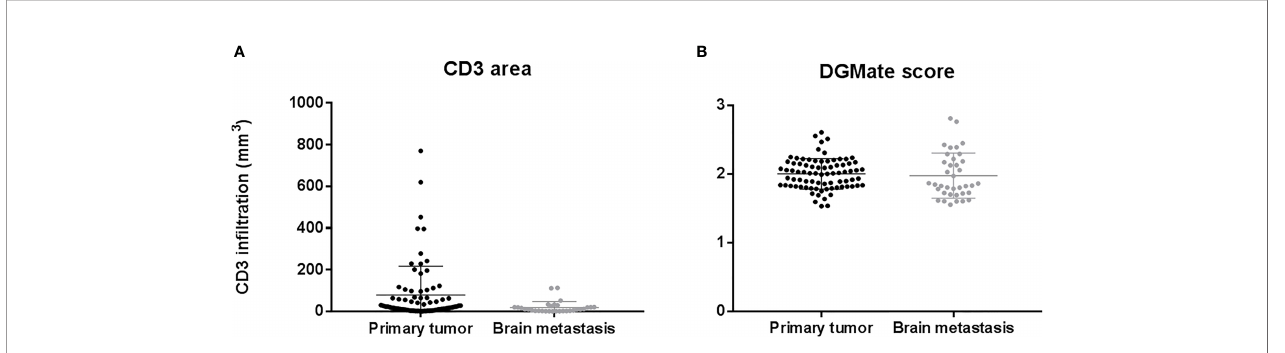
FIGURE 2 | CD3 in fi ltration (A) and DGMate (B) in primary tumor and brain metastases.